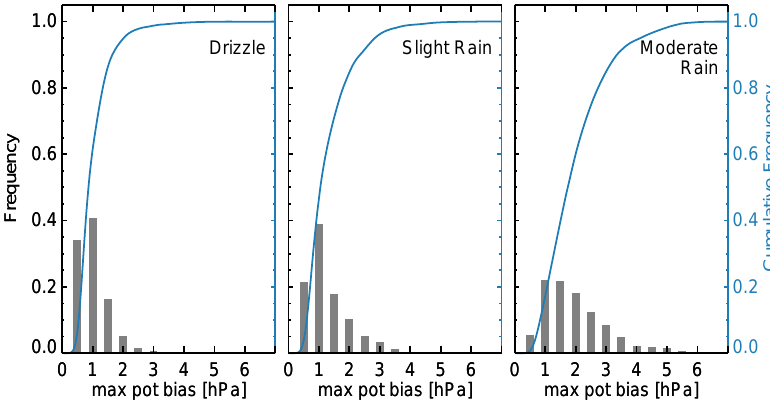
Figure 10. As in Fig. 9 but for precipitating